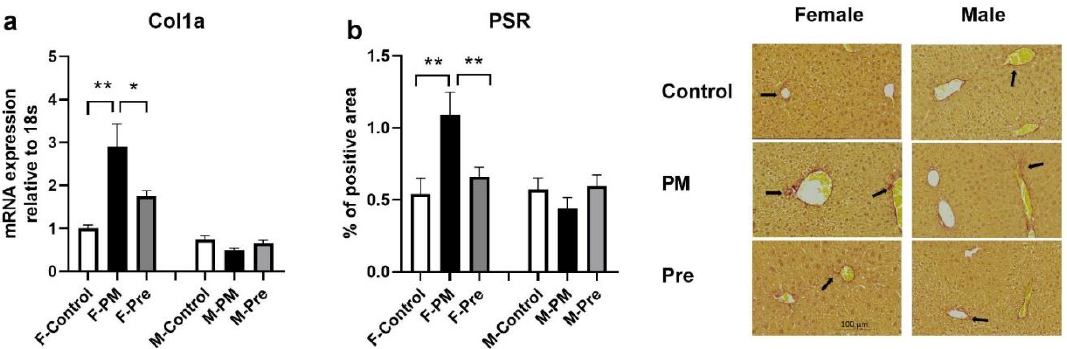
Figure 4. Fibrosis Markers in Female and Male Offspring. mRNA expression level of collagen I α 1 (ColI α 1) ( a ), the relative density of picrosirius red (PSR)-positive area and representative images of PSR staining (indicated by black arrows) ( b ). Results are expressed as mean ± SEM, n = 6 ( a ), n = 5 ( b ). * p < 0.05, ** p < 0.01. PM: offspring from dams continuously exposed to PM2.5; Pre: offspring from dams exposed to PM2.5 before conception only.